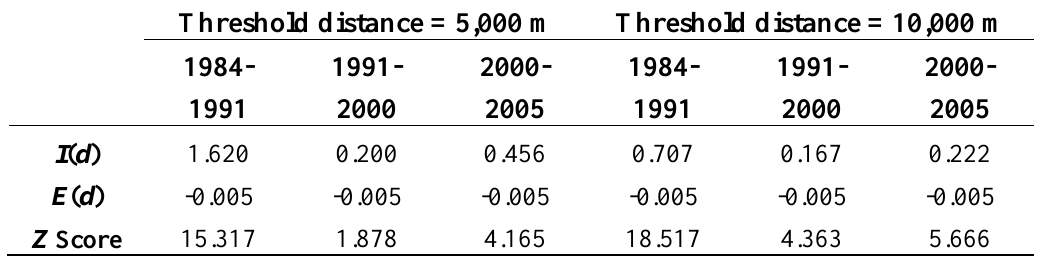
Table 1. Global I of SII whose spatial weights are constructed based on contiguities from the nearest